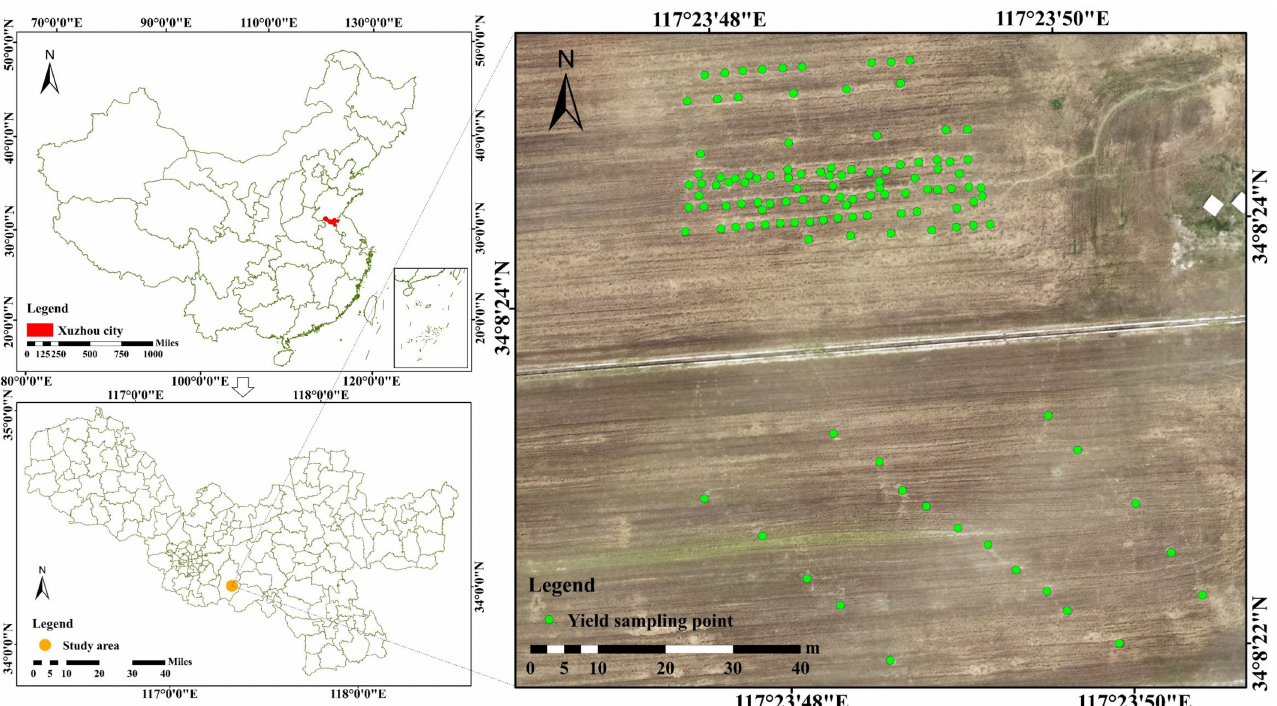
Figure 1. Overview of the study area (the green points represent the centers of the sampling squares of winter